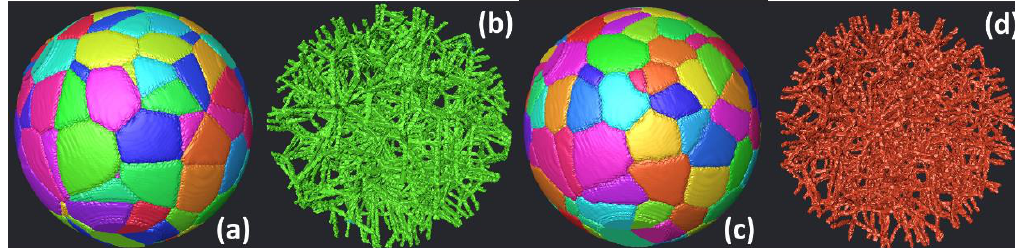
Figure 10. 3D complex cellular structure generated using Voronoi–Monte Carlo scheme ( a ) Voronoi structure, ( b ) cellular network based on Voronoi open-cell boundaries, ( c ) Voronoi–Monte Carlo structure after 40 MCS, and corresponding ( d ) cellular structure.